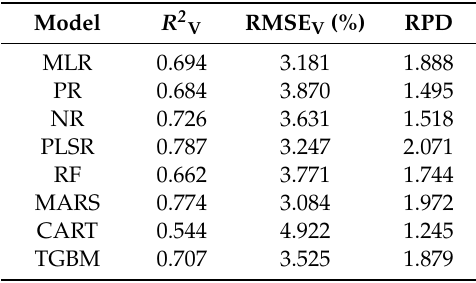
Table 4. Validation set model accuracy evaluation.